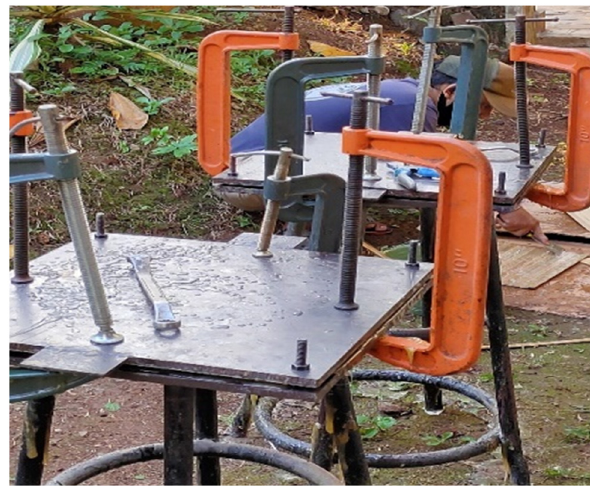
Figure 4: Laminate board pressing